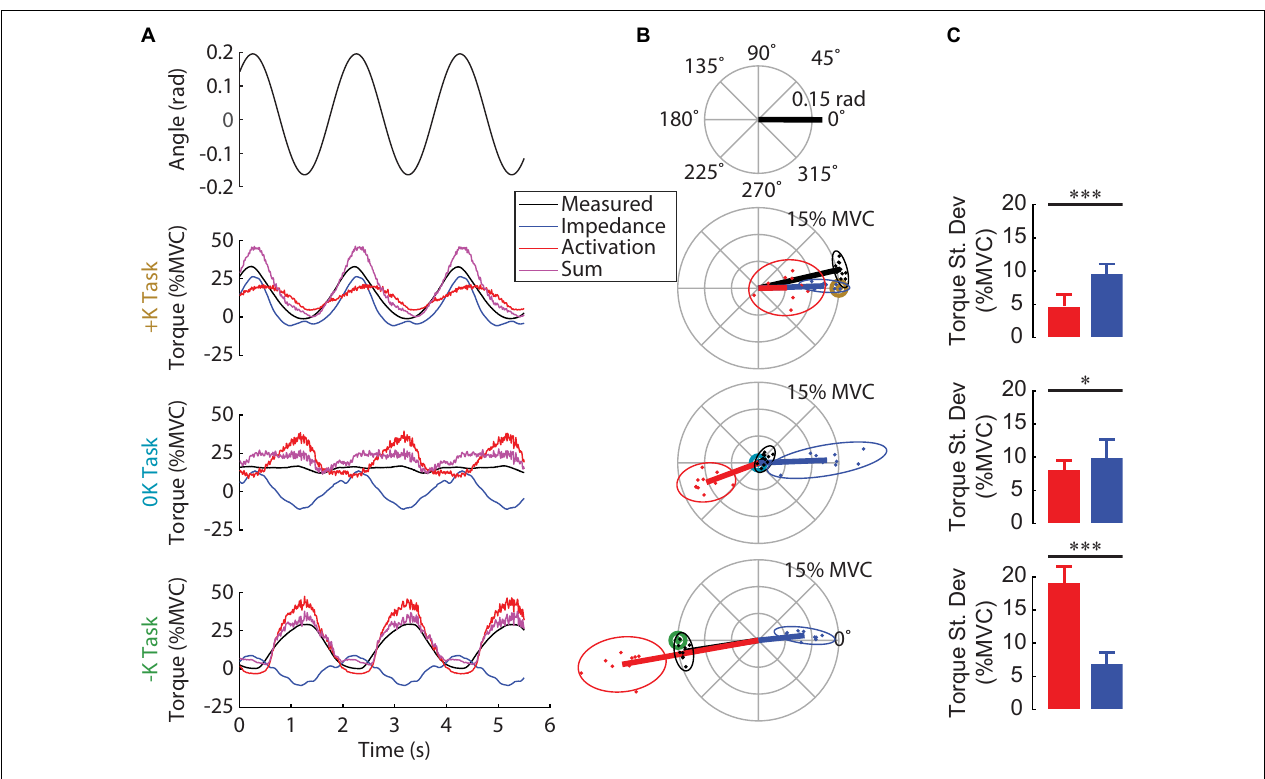
FIGURE 5 | Contribution of impedance and muscle activation to the torque generated in the three tasks. (A) Ankle angle, measured torque, torque due to impedance, torque due to muscle activation and their sum for all three tasks for one subject. The sum of the two modeled torque components was a good fit for the measured torque for this subject in all three tasks. (B) Polar plot showing the phase and magnitude of the different torque components for all subjects. For each task, the target torque is denoted by a bullseye. Since the torque due to impedance was always in phase with the imposed movement, muscle activation was required to compensate for the impedance when it was not beneficial to task performance. (C) The torque due to impedance was greater than the torque due to muscle activation in the + K task, whereas these torques were of similar magnitude in the 0K task, and had a reversed order of dominance in the –K task ( ∗ p < 0.05, ∗∗ p < 0.01; ∗∗∗ p < 0.001). We conclude that subjects completed the + K task by relying more on ankle impedance and reducing muscle activity compared to the other two tasks.